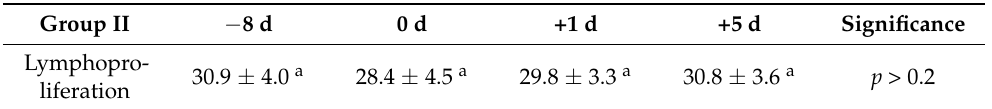
Distinct letters on the same line indicate a significant statistical difference between the results, 0 d = immediately after the race.